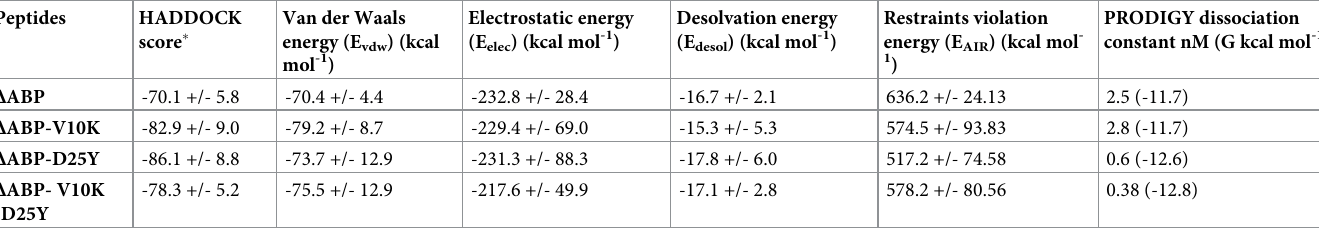
HADDOCK docking analysis suggests that all Δ ABPs bind at the RBM site of S protein. The bound Δ ABPs cover the whole surface of the RBM site. However, Δ ABPs binding does not exactly overlap with the α 1/ α 2 of ACE2 (Figs 3B and 4A). The position of α 1 helix of both ACE2 and ABP is very similar. However, the α 2 helix of ACE2 and Δ ABP are situated in a dif- ferent plane and do not overlap with each other (Figs 3B and 4A). The α 2 helix of ACE2 does not form direct contact with the virus RBD whereas both helices of Δ ABP interact with the Table 2. HADDOCK docking statics and PRODIGY server binding affinity of various Δ ABPs. Peptides HADDOCK score